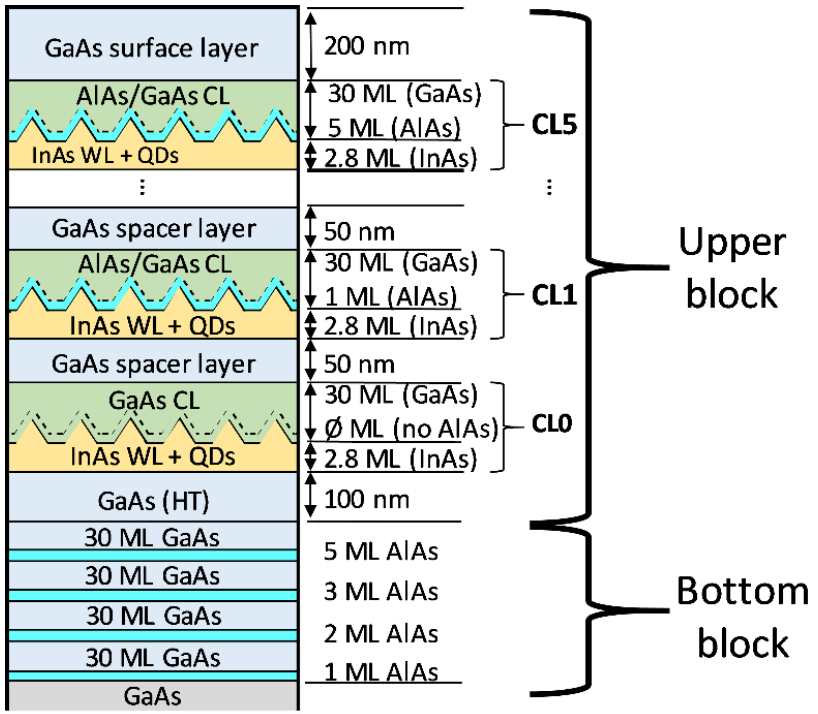
Figure 1. Scheme of the sample. In the first block, AlAs thin layers were grown for calibration. In the second, five layers of InAs QDs were covered by AlAs CLs with different thicknesses.